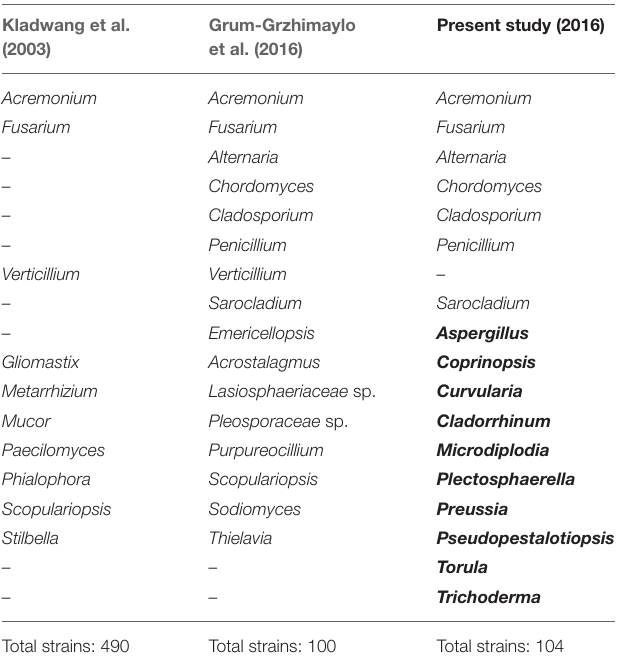
TABLE 5 | Comparison of present and previous fungal studies on Soda lake around the world. Kladwang et al. (2003)